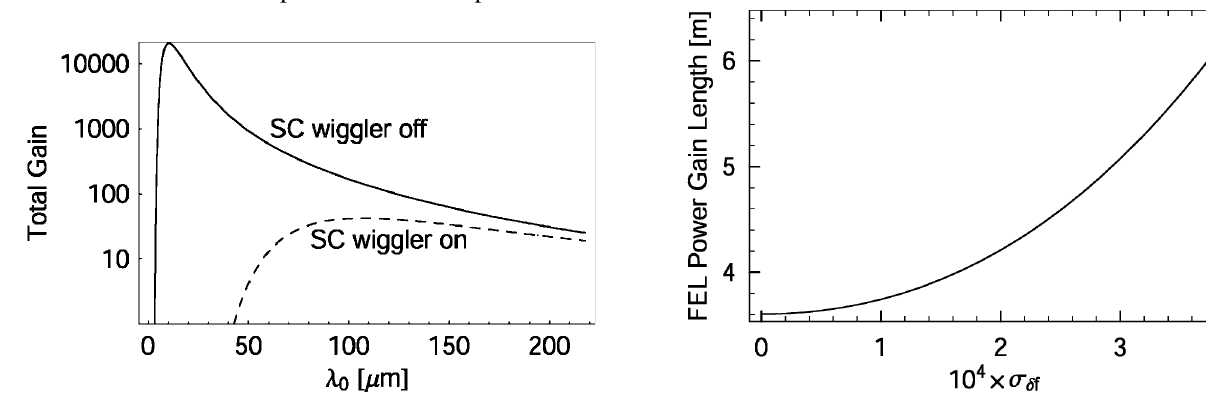
at the undulator entrance (cid:31) f